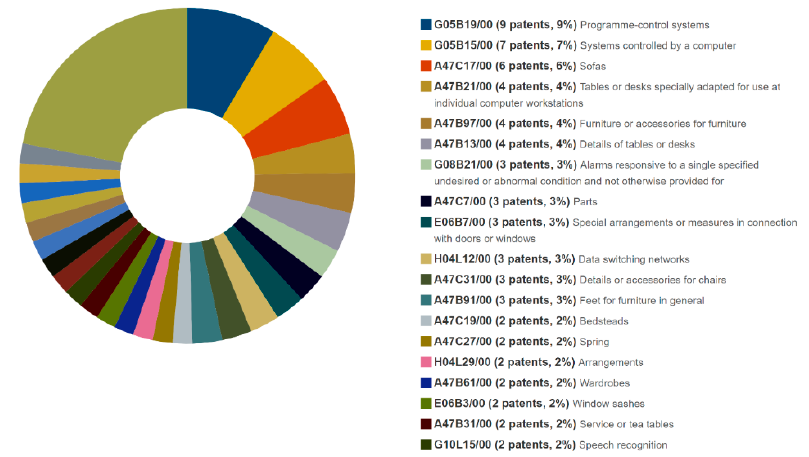
Figure 5. International Patent Classification (IPC) Codes for our patent pool.